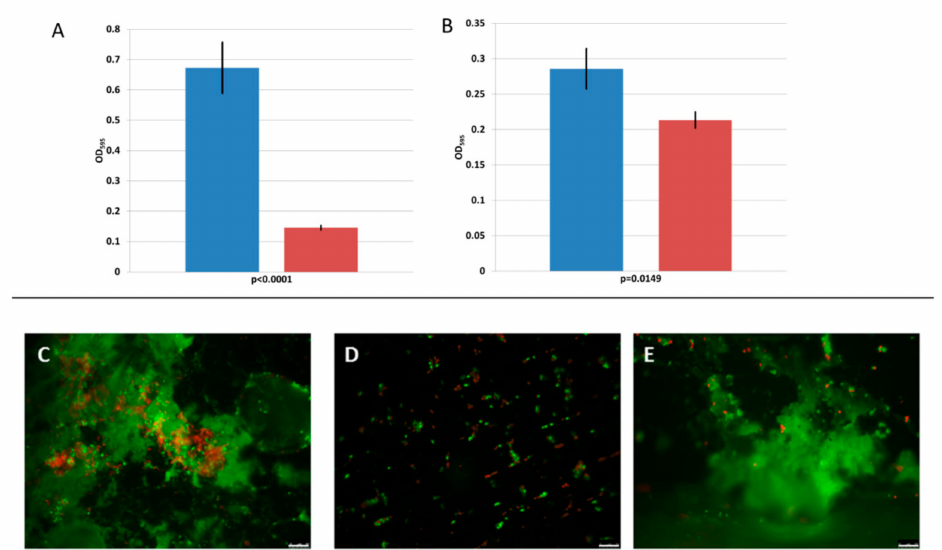
Figure 4. Biofilm prevention ( A ) and biofilm removal ability ( B ) of the 293-amidase (75 µ g / mL) against L. monocytogenes 473 in microtiter plates assays. The blue bars represent the controls (untreated biofilm) and the red bars the treatments. Values are the average of triplicates and the standard deviation is represented as error bars. The p -values are shown below the horizontal axes. ( C – E ) The images obtained from the stainless-steel coupons assays. ( C ) L. monocytogenes 473 biofilm after 4 days of incubation at 20 ◦ C. ( D ) Co-inoculation of L. monocytogenes 473 and 293-amidase (150 µ g / mL). ( E ) The application of 293-amidase (150 µ g / mL) on a 4 day old biofilm. The red-stained cells were damaged or dead, while the green stained cells were alive. The scale bars at the bottom-right in ( C – E ) are 10 µ